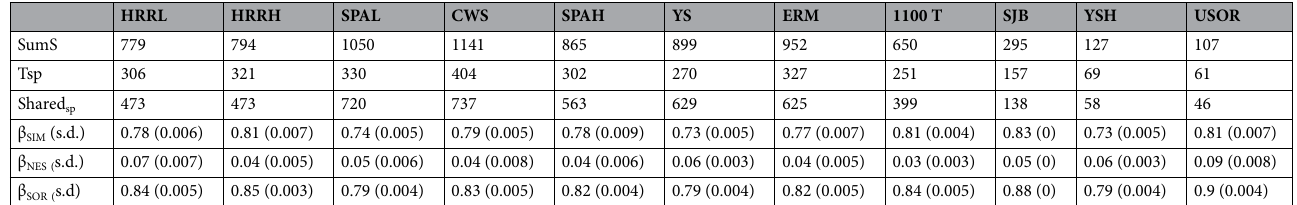
Table 4. Results from the partitioning of beta diversity of moth assemblages at 11 sites in HNP. Sum S, the sum of the species richness values of all years; T sp the total richness in the dataset; Shared sp , the number